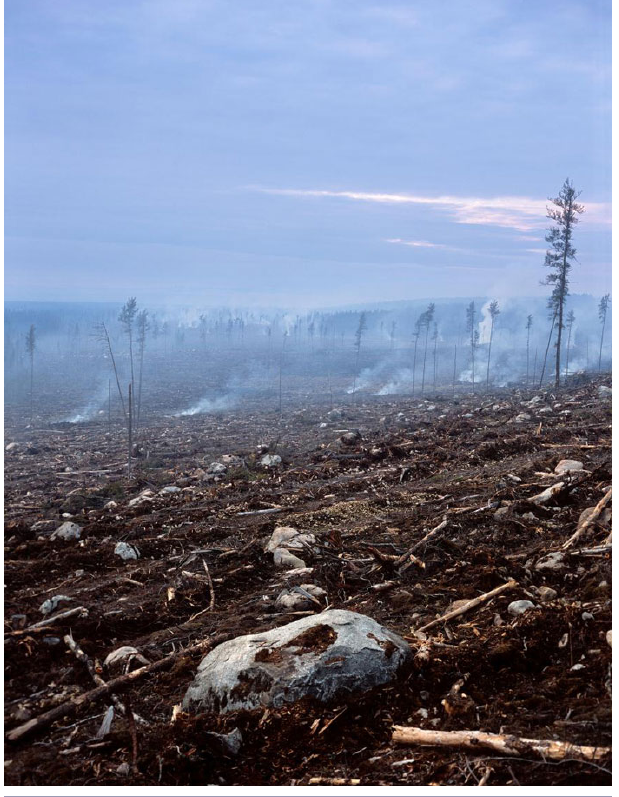
Fig. 1 . A timber harvest site adjoining the Whitefeather Forest Planning Area is “scarified,” prepared for planting by scraping woody material and organic soils into piles for burning. This process exposes mineral soil for replanting of seedling trees and reduces hazardous fuel accumulations, but is seen by Pikangikum elders as disrespectful of the land and injurious to the healing processes. (Photo: N.